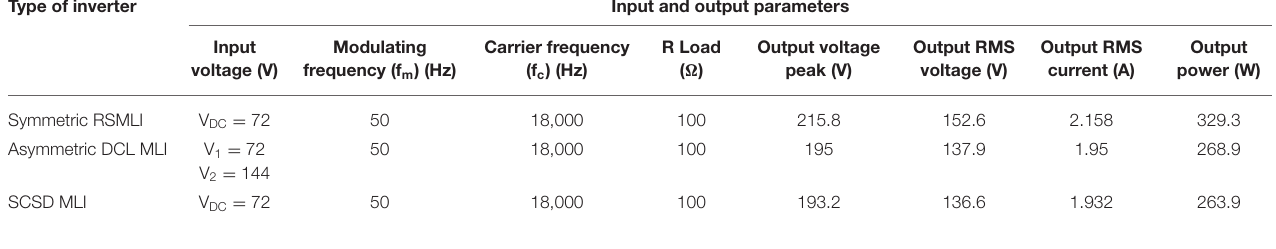
TABLE 3 | Parameters of various